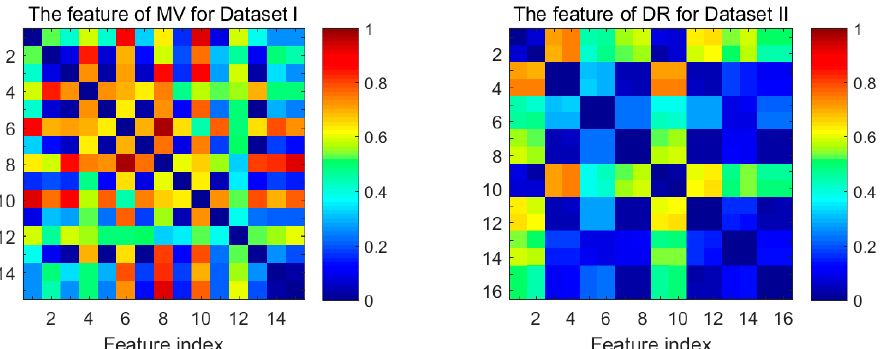
Figure 3. Visualization of the dissimilarity matrix of MV and DR.